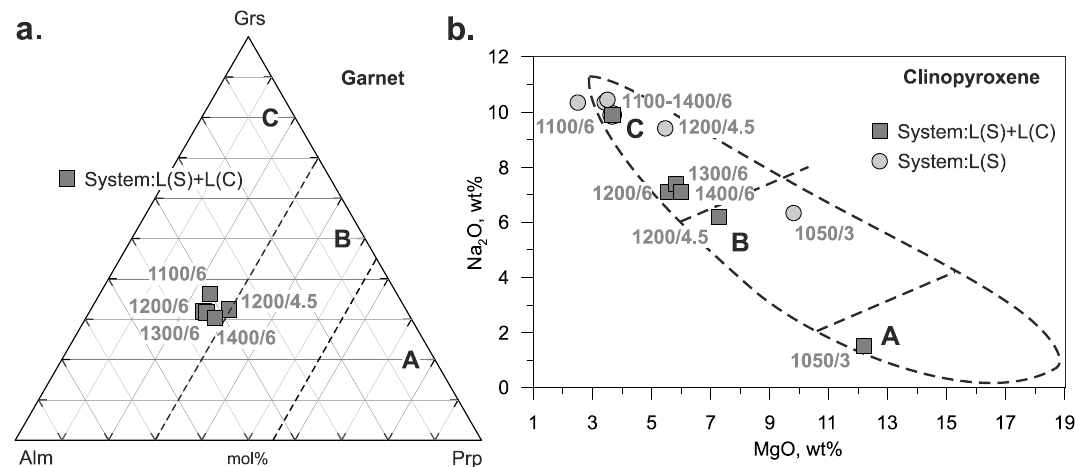
Figure 11. Compositions of Grt ( a ) and clinopyroxene ( b ) form the present experiments. ( a ) Ca-Mg-Fe diagram. Group A, B, and C according to the classification of Coleman et al. [42]. ( b ) Na 2 O vs. MgO in clinopyroxenes. Group A, Group B, and Group C according to the classification of Taylor and Neal [41].